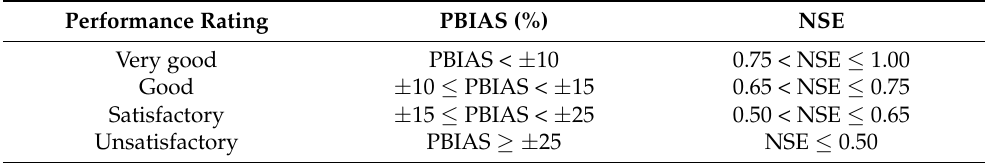
Table 4. General performance ratings for statistics